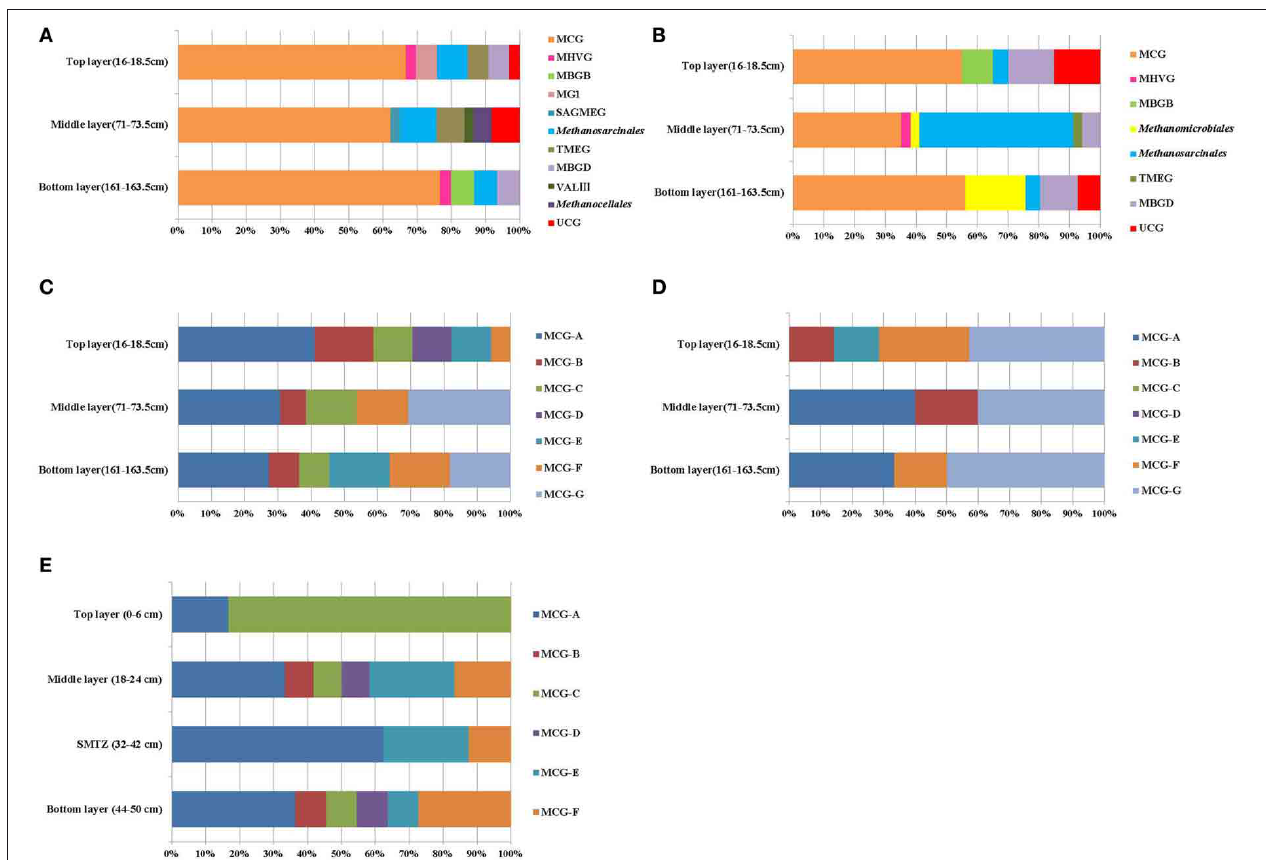
FIGURE 2 | Compositions of archaeal members in 16S rRNA gene clone libraries (A) and 16S rRNA clone libraries (B), MCG subgroups in the 16S rRNA gene clone libraries (C) and 16S rRNA clone libraries (D), and MCG subgroups in 16S rRNA gene clone libraries of Pearl River Estuary (E). Groups shown include Miscellaneous Crenarchaeotal Group (MCG), marine